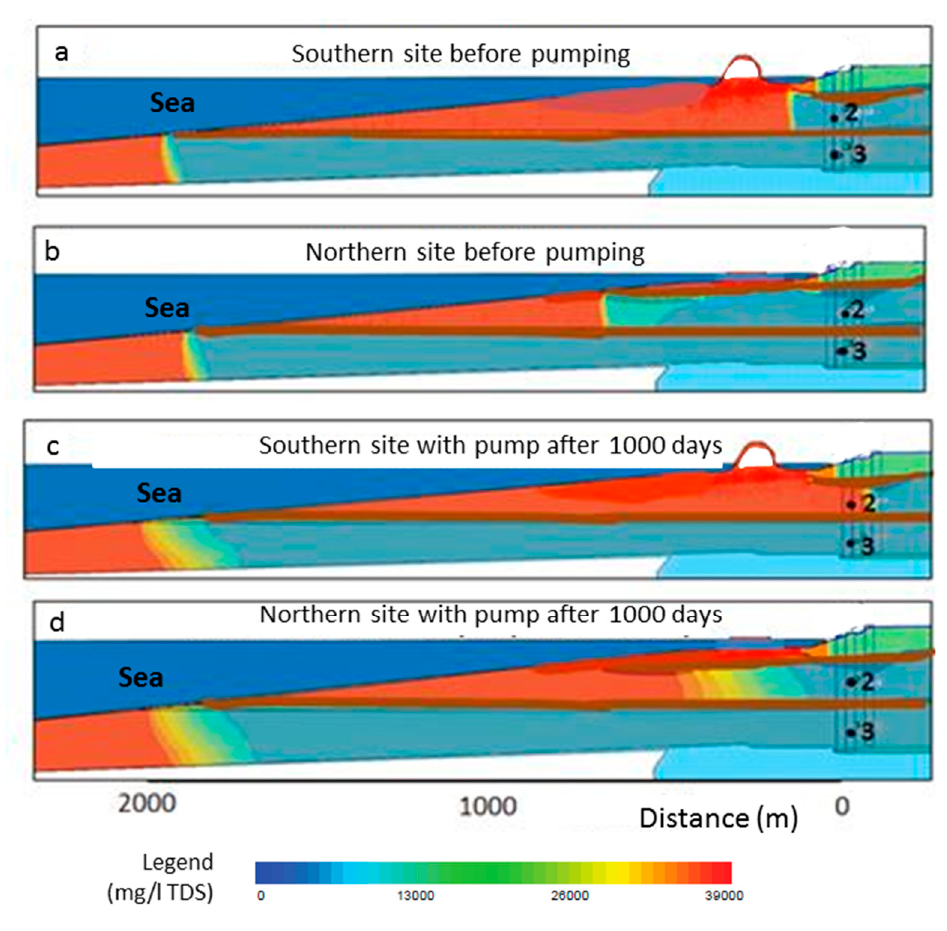
Figure 10. The location of the fresh–saline water interfaces in the different sub-aquifers: before pumping in the southern site ( a ); and in the northern site ( b ); after 1000 days of pumping with eastern boundary water level of +3 m, in the southern site ( c ) and the northern site ( d ). “2” and “3” denote units B and C.